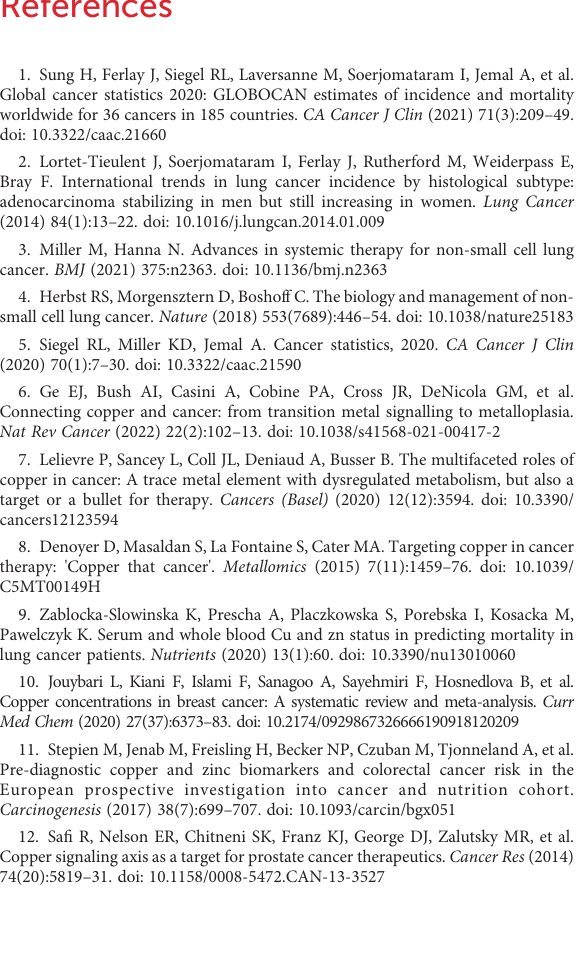
SUPPLEMENTARY FIGURE 2 Strati fi ed survival analysis based on CMRGS. (A) Age<70 and Age>=70. (B) Female and male. (C) T1+T2 and T3+T4. (D) N0 and N1+N2+N3. (E) M0 and M1. (F) Stage I+II and Stage III+IV.